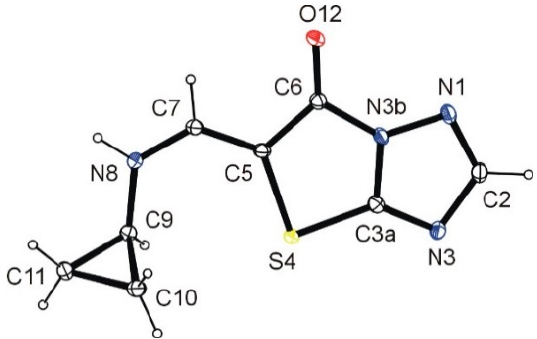
Figure 5. A view of 5c , showing the atomic labelling scheme. Non-H atoms are drawn as 30% probability displacement ellipsoids and H atoms are drawn as spheres of an arbitrary size.